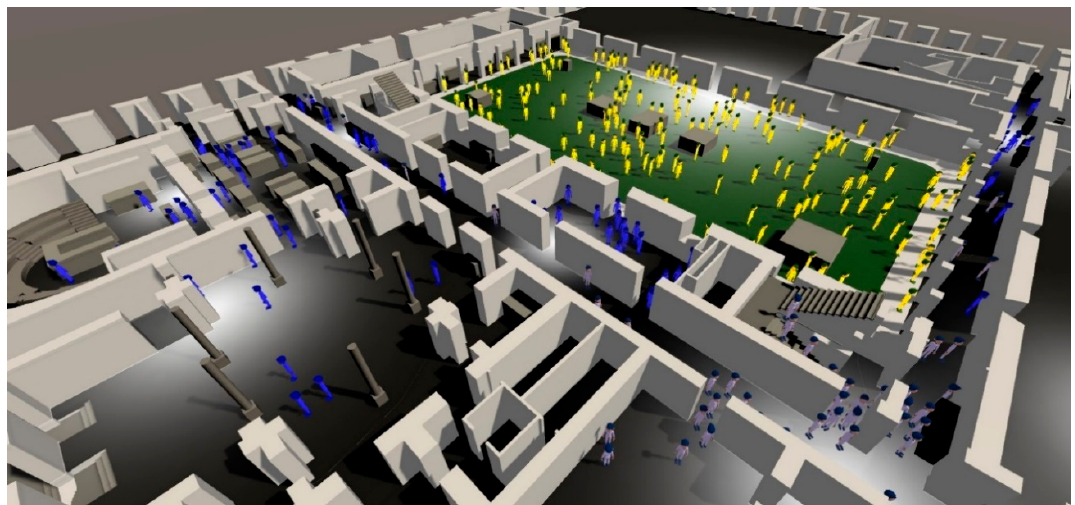
Figure 19. Users’ collective thermal perception. color-coded into avatars.